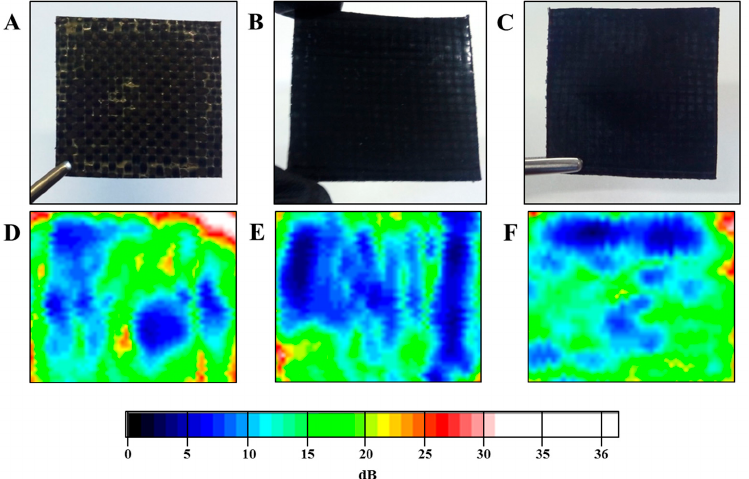
Figure 2. Photographs (upper row) and ultrasonic attenuation C-scans (bottom row) of PEEK/CF ( A , D ), PEEK-GPEI/CF ( B , E ), and PEEK-GSPEEK/CF ( C , F ). The colour scale is associated to the ul- trasonic signal attenuation measured in dB.